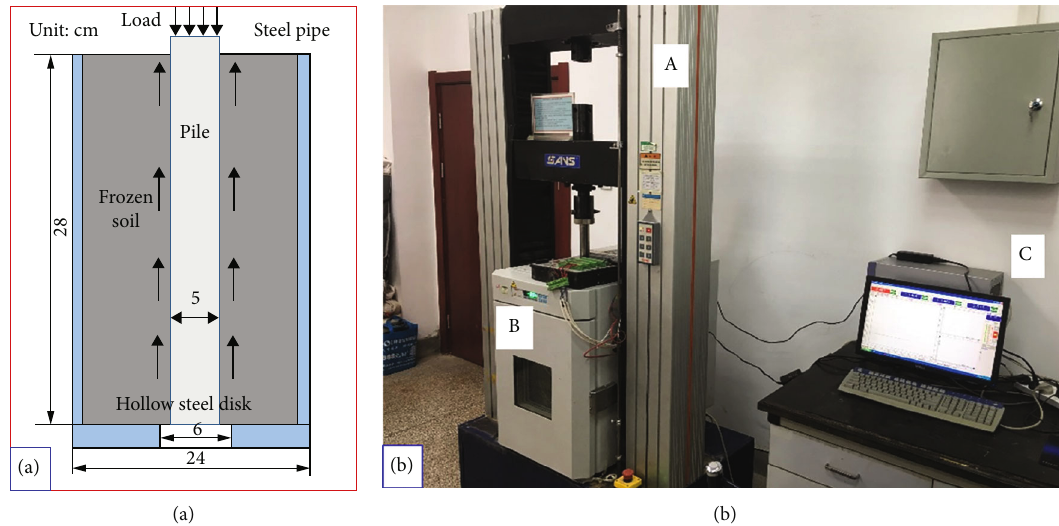
Figure 1: Pile-frozen soil structure (a) and creep testing apparatus (b). (A) Material testing machine. (B) Thermostats. (C) Data collection system for displacement and load.